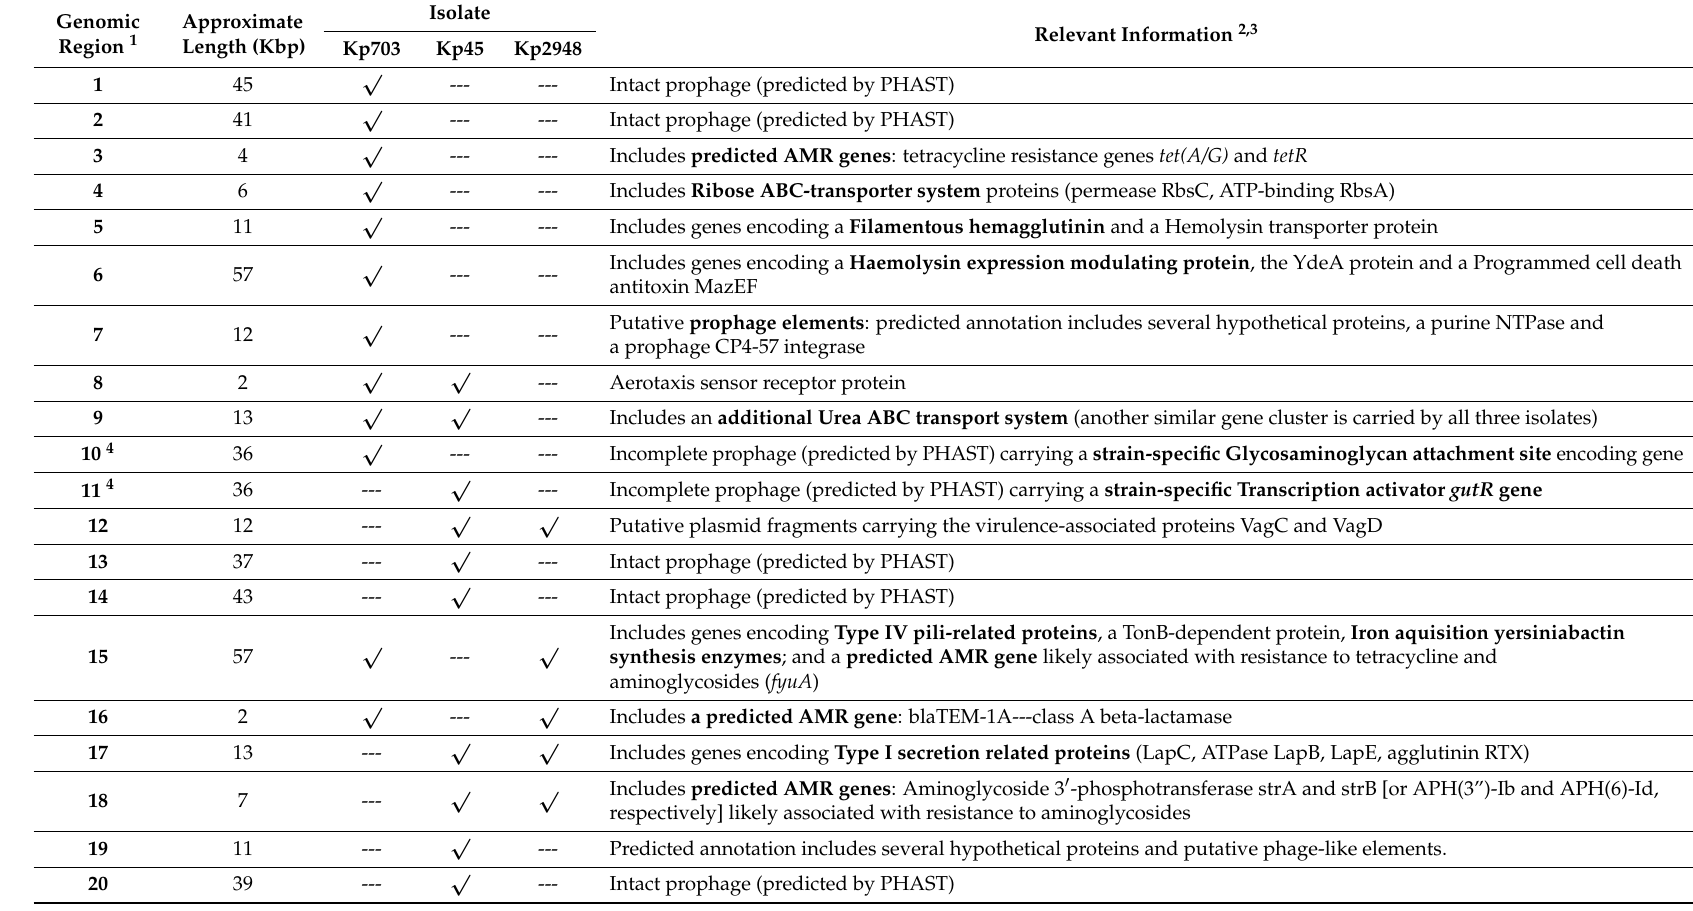
Table 1. Genetic differences in the accessory genome of the K. pneumoniae